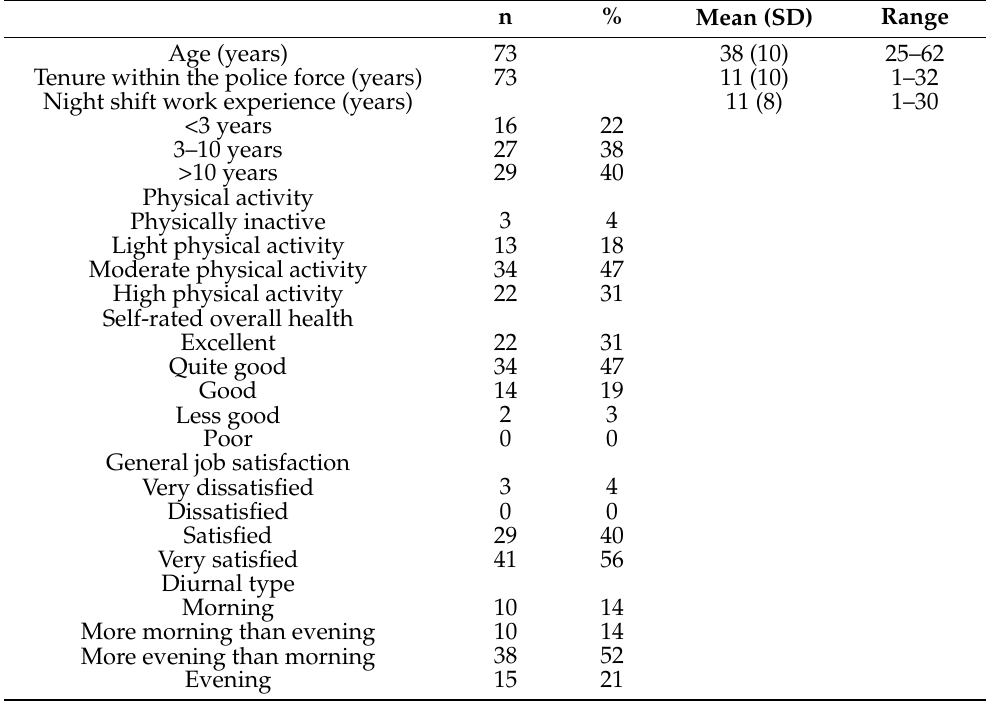
Table 1. Description of 73 participating police